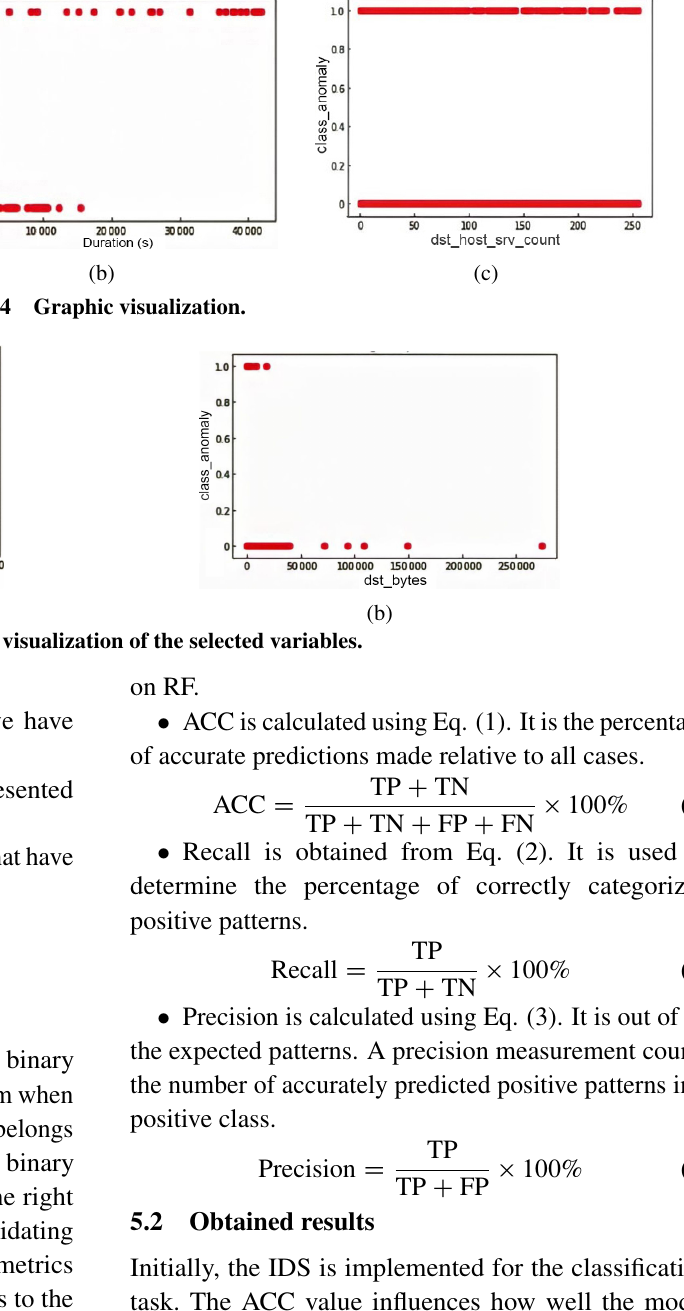
Fig. 4 Graphic visualization.